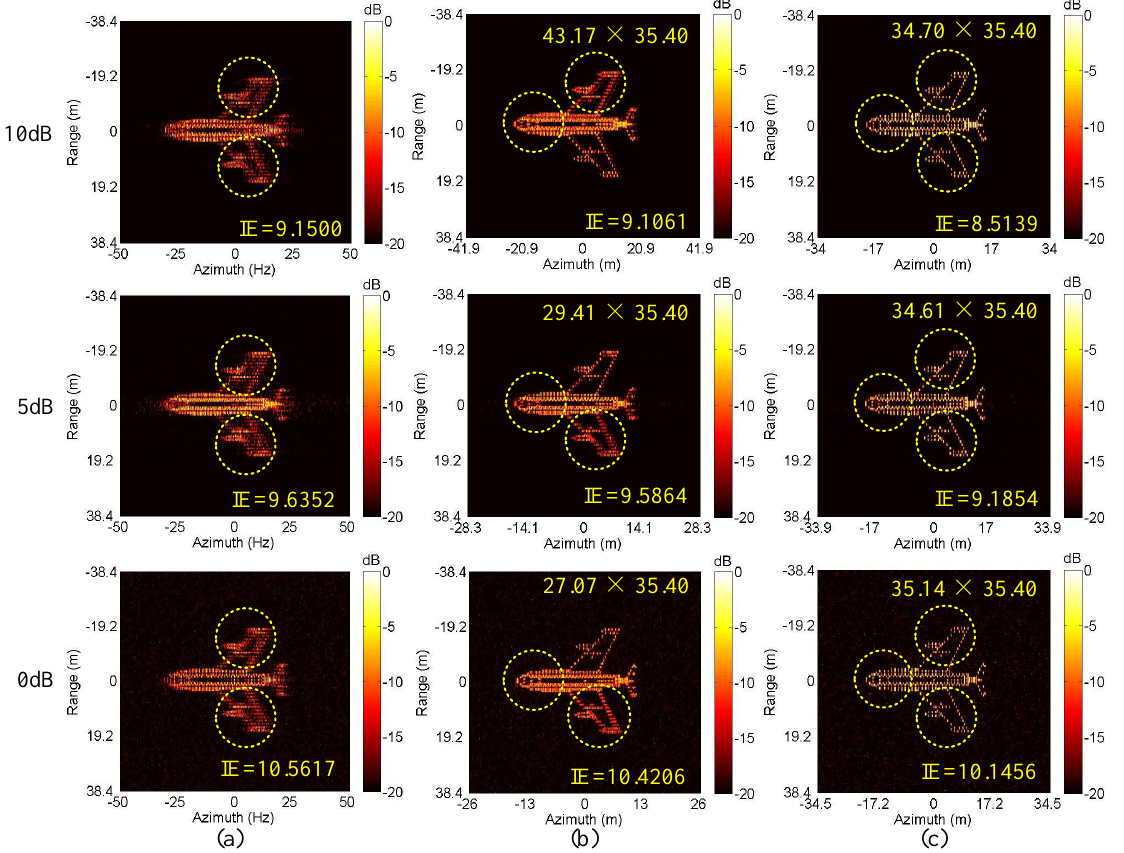
Figure 6. The imaging results of di ff erent algorithms at di ff erent SNRs corresponding to NCM. ( a ) IMCM-PGA. ( b ) IMCM-PGA-TAS. ( c ) IMCM-PGA-MJAAS.